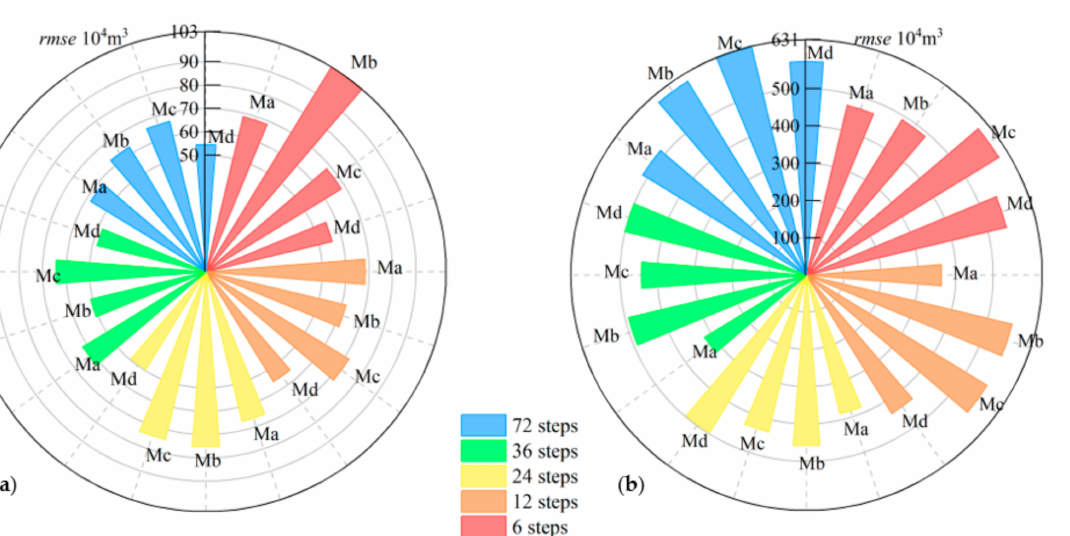
Figure 8. Rose plots for different combinations of inputs and outputs in the two hydrological stations for the sequential IGWO-GRU model. ( a ) Rose plots for Shangjingyou station; ( b ) Rose plots for Fenhe reservoir